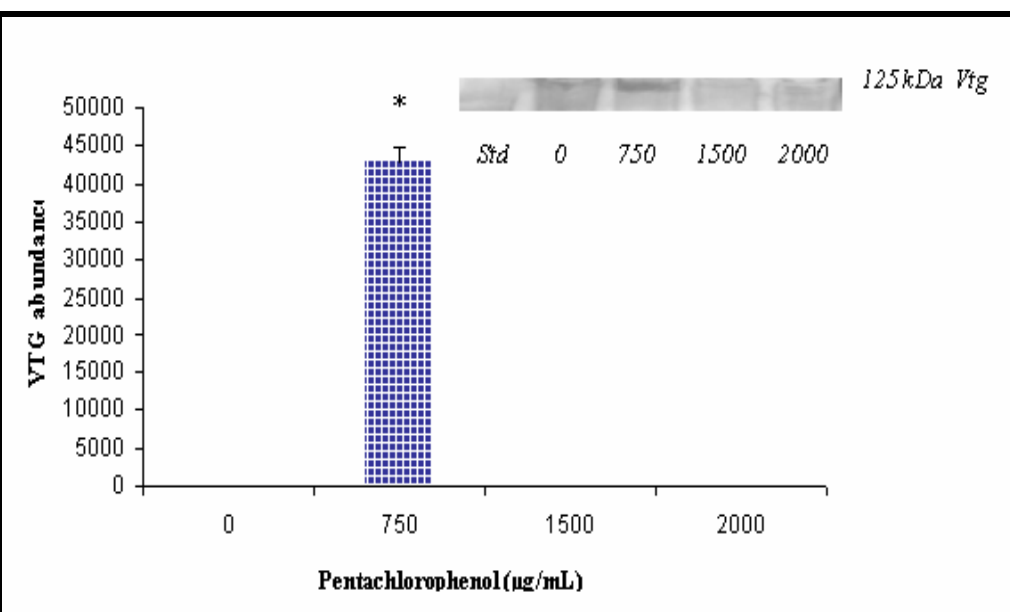
Figure 4: Western Blot for Vtg expression and densitometric analysis in PCP-treated channel catfish hepatocytes. Inset shows representative Western analysis. Densitometric analysis shows a significant increase in Vtg abundance at 750 ug/mL. Bar represents Vtg abundance; values are means + SDs, n = 3. *Significantly different from control (0 µ g/mL PCP), p < 0.05